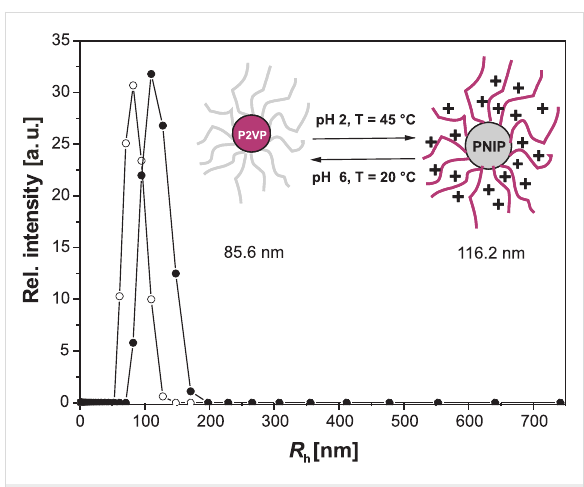
Figure 9: Hydrodynamic radius distribution of P(2VP) 105 -b- P(NIPAAm) 332 at ○ pH 7, T = 20 °C and ● pH 2, T = 45